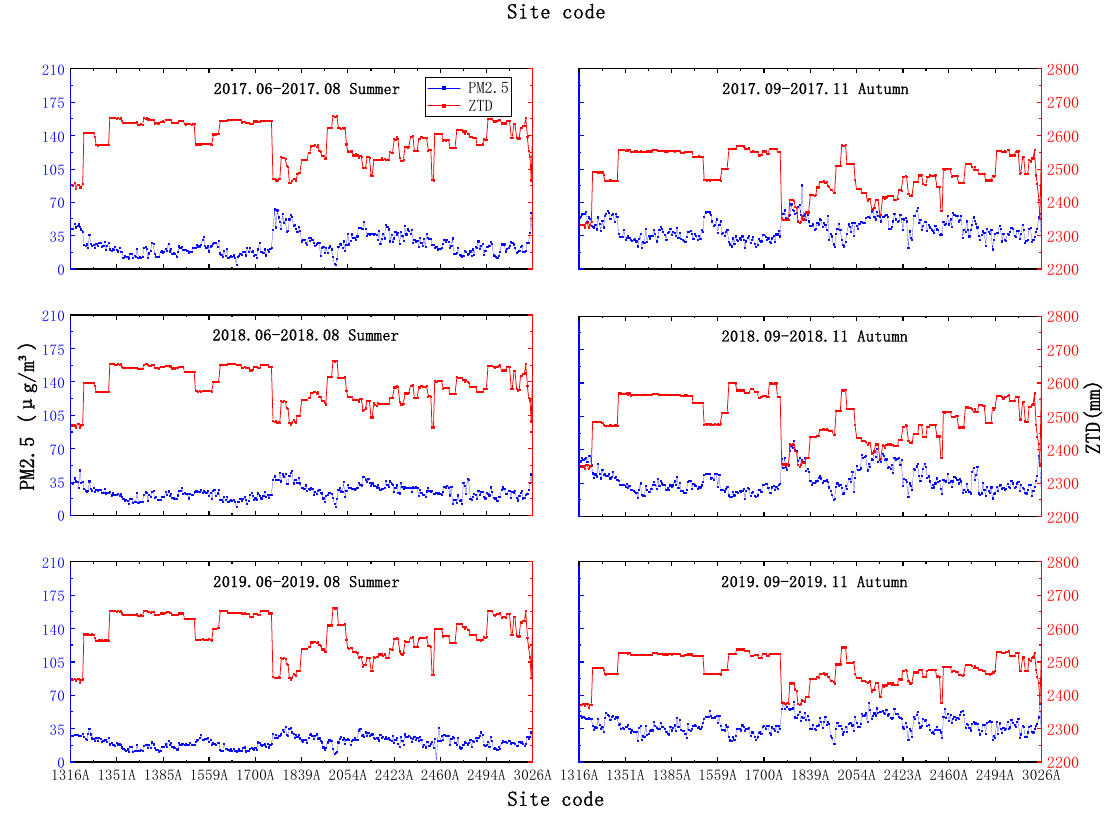
Figure 6. Seasonal average-scale ZTD and PM 2.5 changes. As seen in Figure 7, PWV and ZTD seem to be the lowest and have the smallest var- iation ranges in winter, with variation ranges below 30 mm; the highest values and largest variation ranges are observed in summer, with values varying above 40 mm, while the variations in PWV and PM 2.5 recorded in spring and autumn range between 20 mm and